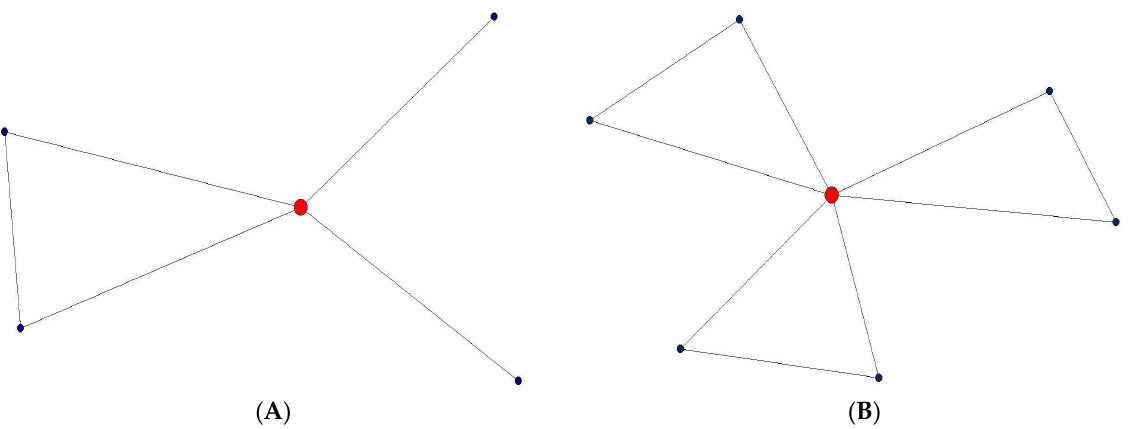
Figure 1. ( A ) A less constrained confidant network of a clinically depressed participant. ( B ) A more constrained confidant network of a clinically depressed participant.